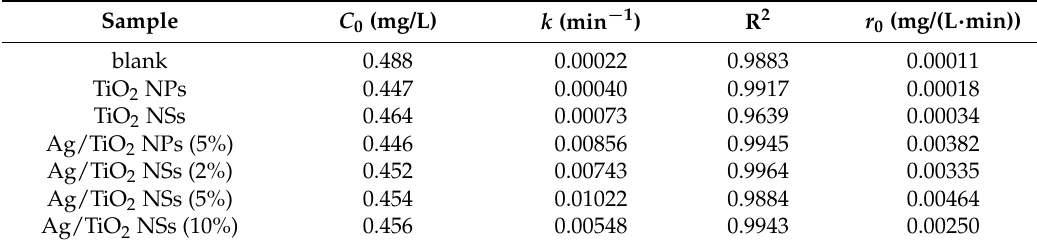
Table 1. The related parameters obtained from kinetic